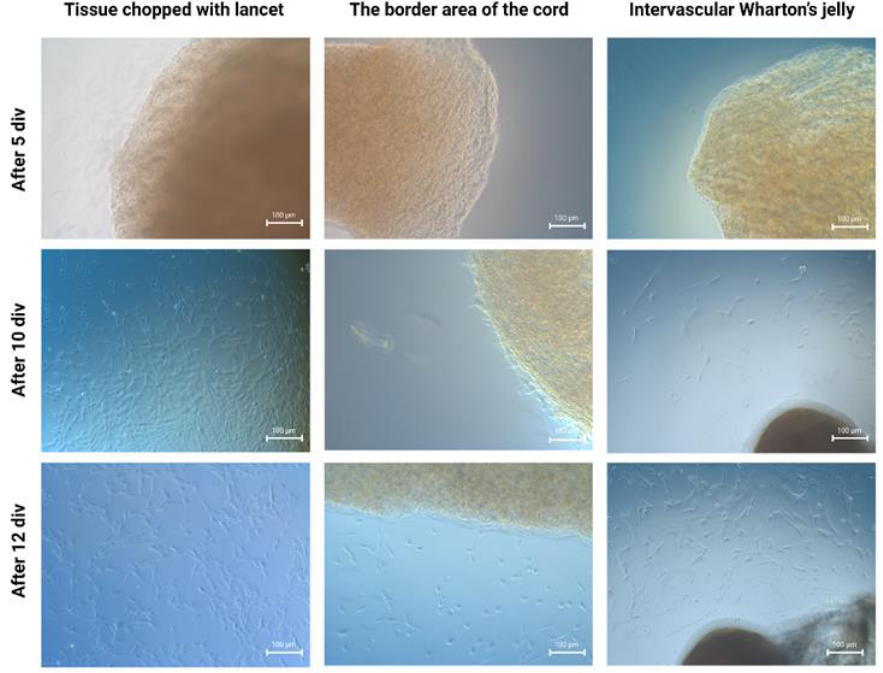
Figure 1. Isolation of MSCs from different regions of the UC. The rate of cell migration out of bioptats and tissue fragments was observed for 12 days (div—days in vitro) ( n = 3). Scale bars: 100 µ